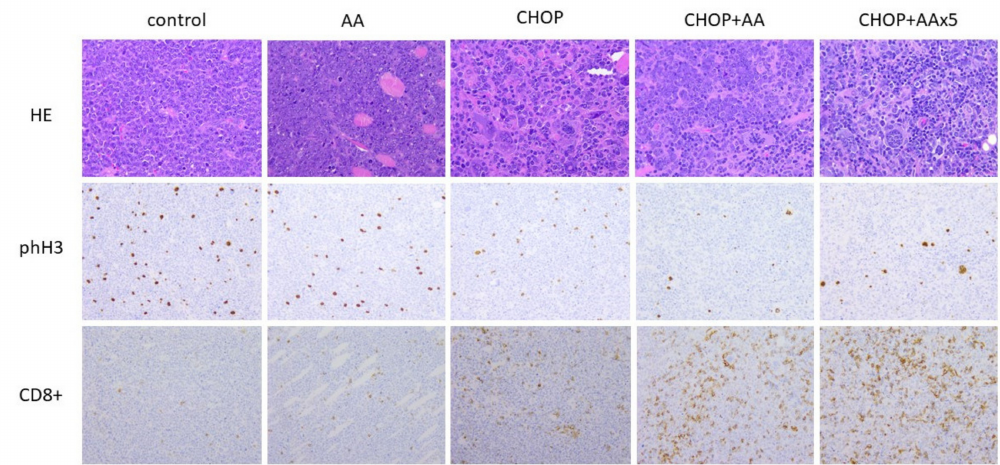
Figure 3. Intratumoral e ff ects of CHOP and adjuvant AA determined by histology. Top row: General morphology of A20 lymphoma cells with giant cell transformation as a result of CHOP treatment ( × 40 magnification). Middle row: phospho-histone H3 immunolabeling demonstrating significant drop in cellproliferationactivityfollowingCHOP,CHOP + AAandCHOP + AAx5treatments( × 20magnification). Bottom row: increase of CD8 + immunolabeling following CHOP + AA and CHOP + AAx5 compared to the control, AA and CHOP groups ( × 20